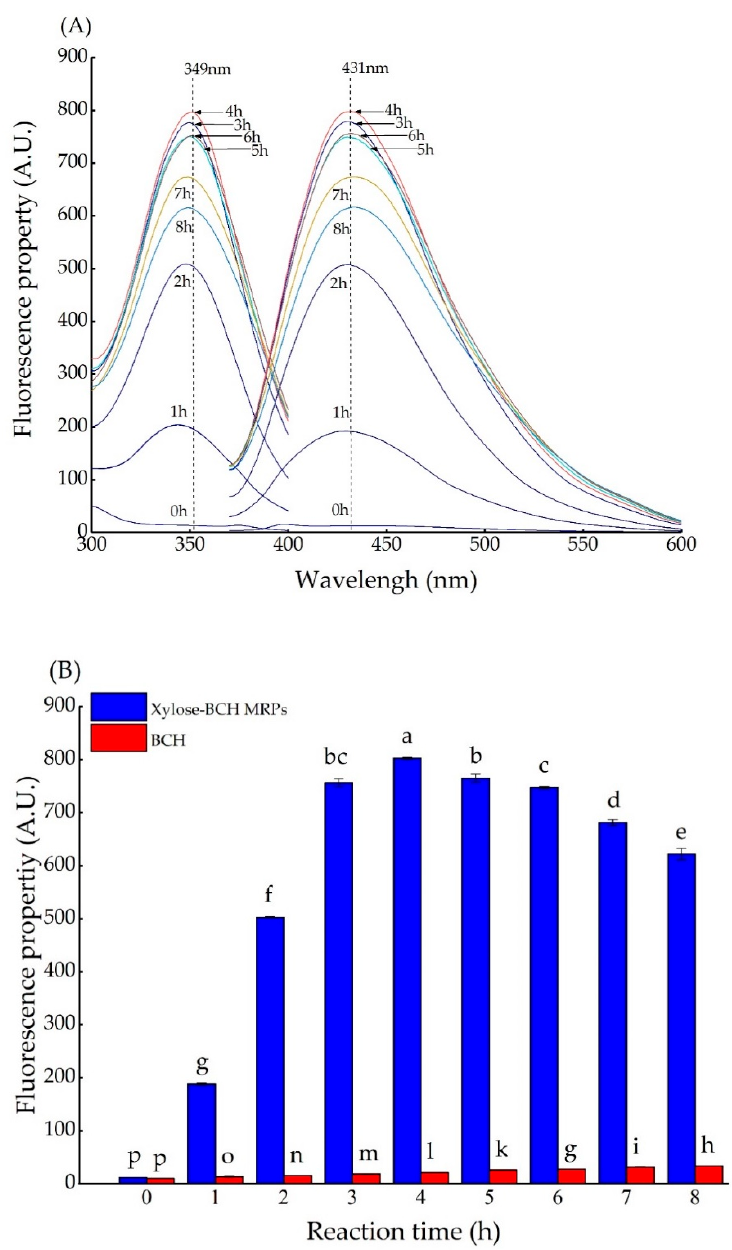
Figure A3. Effect of Maillard reaction time on the fluorescence spectrum ( A ), and fluorescence property ( B ) of xylose–BCH MRPs. In ( B ), a comparison with BCH was reported, and data points with diverse letters are significantly different ( p < 0.05).